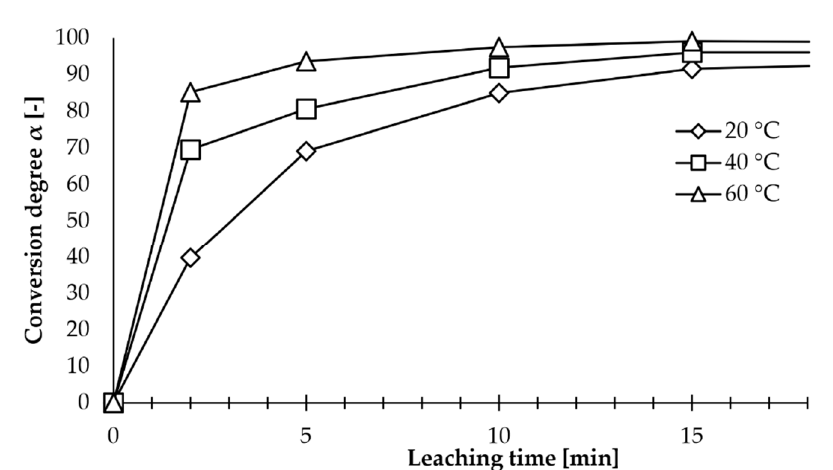
Figure 10. Input kinetic data of lithium leaching used for apparent activation energy calculations.